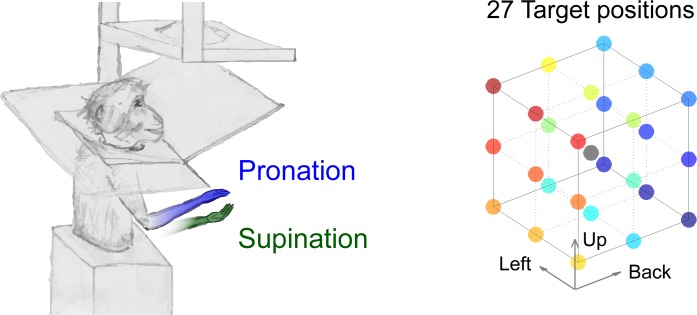
Monkeys controlled a cursor in a standard virtual-reality setup, where they held one of 27 targets in 3D space, with their forearm pronated or supinated.